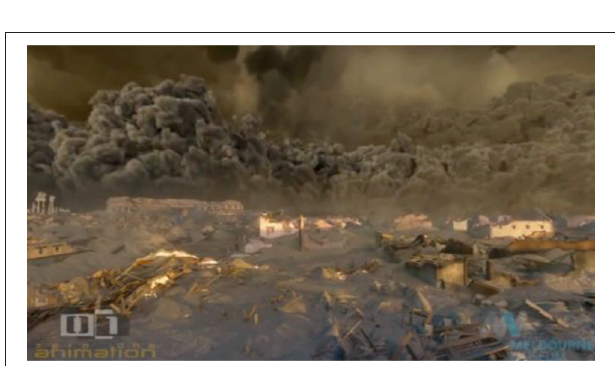
FIGURE 4 | “A day in Pompeii” III, 4 reproduced with the permission of the copyright holder (Zero One Studio).